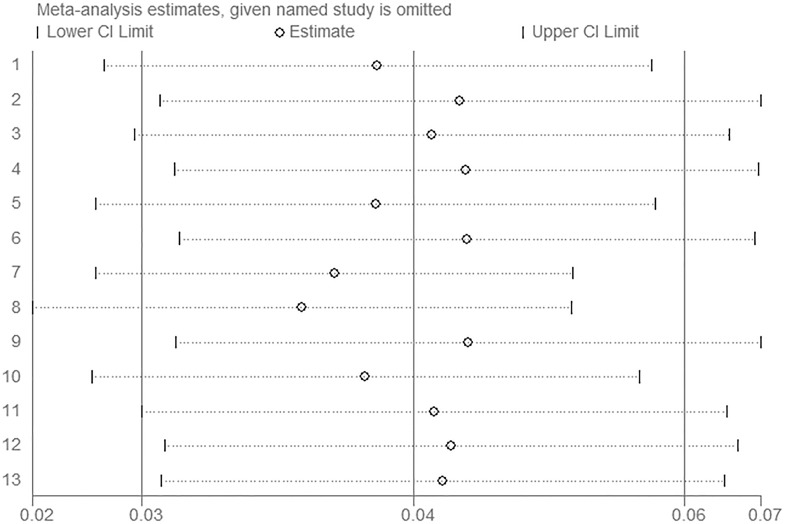
Sensitivity analysis of MRSA prevalence.(A) Results were computed by omitting each study in turn. (B) The two ends of the dotted lines represent the 95% CI.